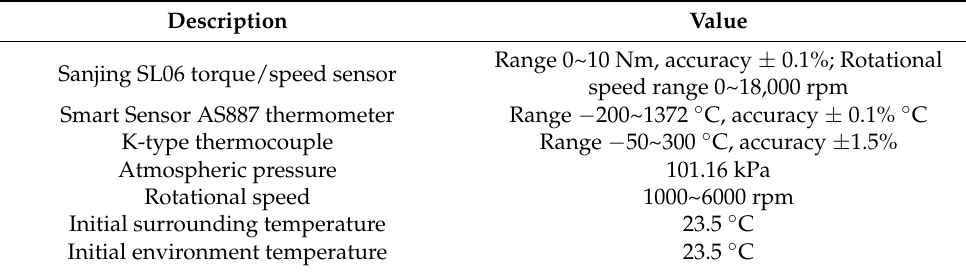
Figure 12. The 2D pump heat transfer experimental setup: ( a ) an overview of the test rig; ( b ) schematic of the cap temperature measurement system. Table 1. The experimental conditions and devices’